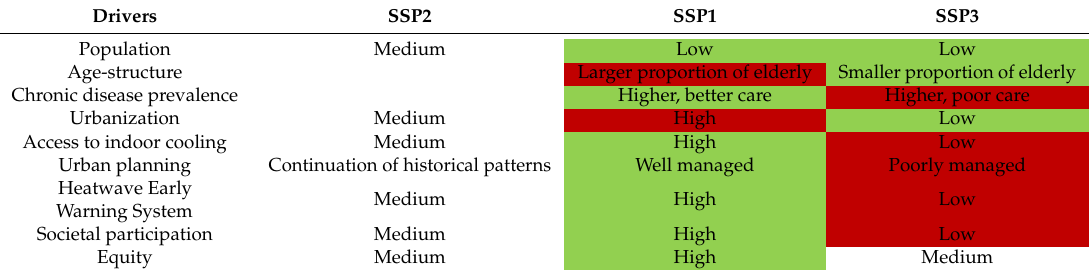
Table 3. Different drivers of heat-related mortality and how they could change under three socio-economic pathways (SSPs). Cells marked with green indicate a lowering of the health impacts and red an increase. Drivers SSP2 SSP1